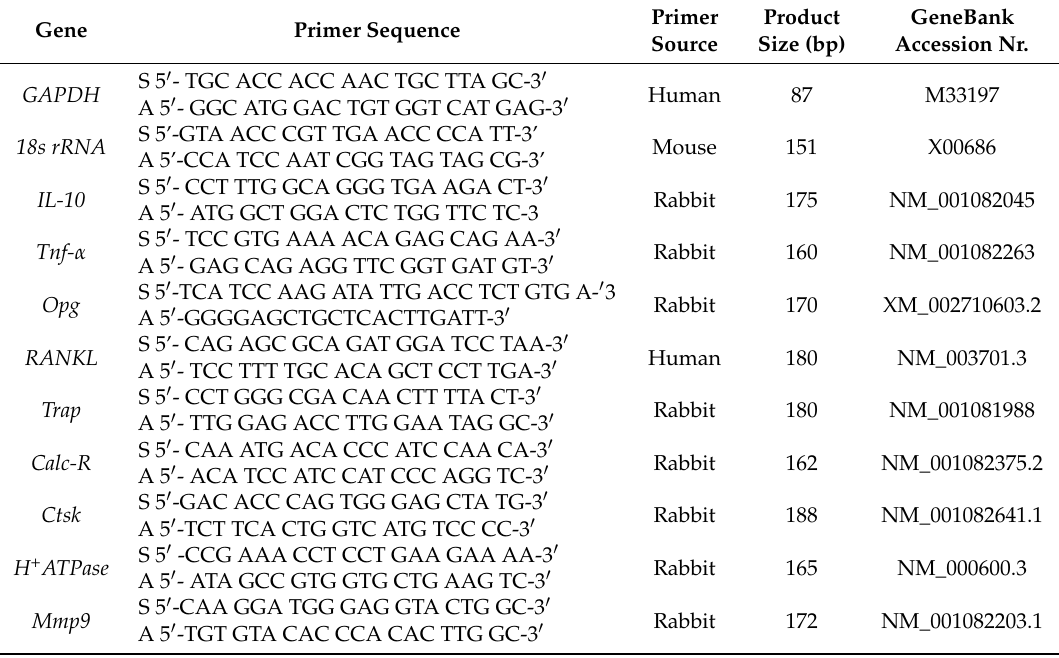
Table 2. Sequence of the specific primers used in the real time RT-PCR analysis of the reference and target genes for the in vivo